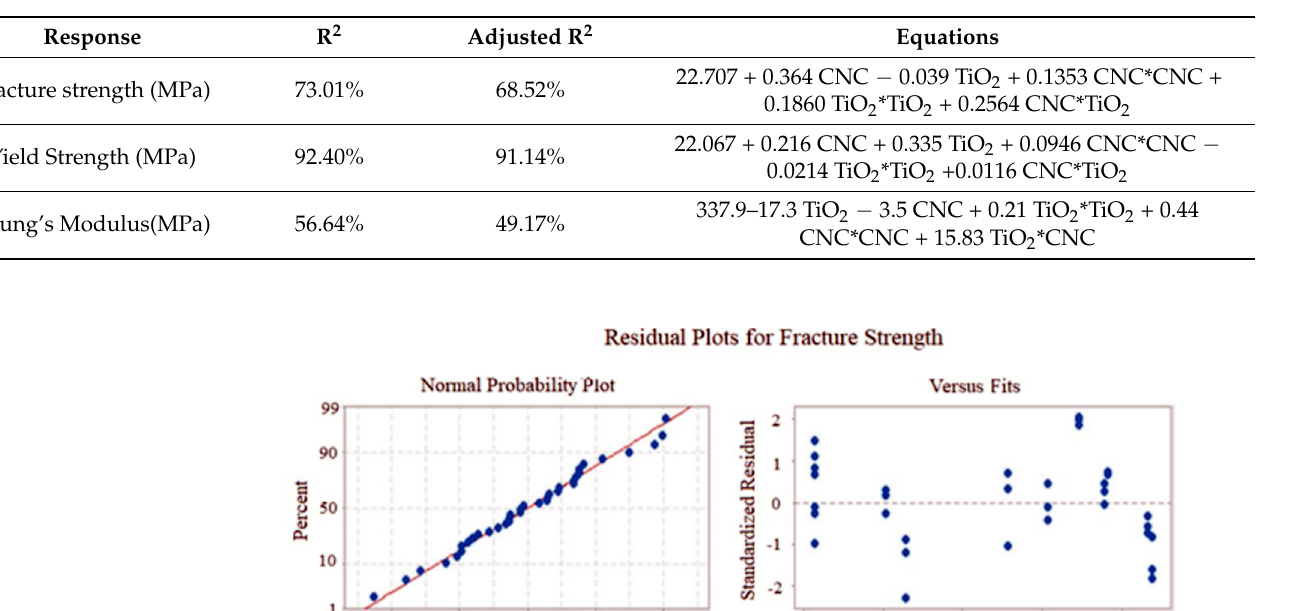
Table 5. The models developed by RSM.